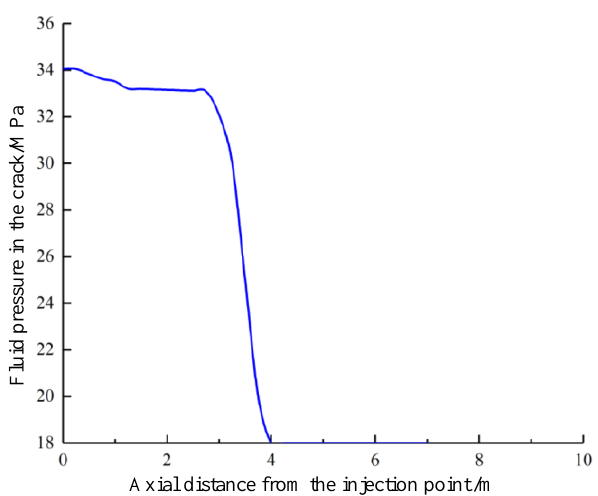
Figure 8. The distribution of fluid pressure along the axial crack of the cement sheath.